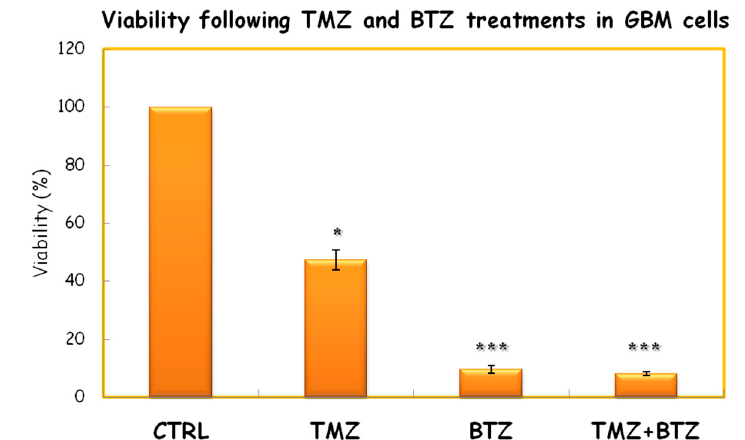
Figure 2. Percentage of 2D culture GBM cell viability treated with temozolomide and bortezomib. * p < 0.05 versus control, *** p < 0.001 versus control .